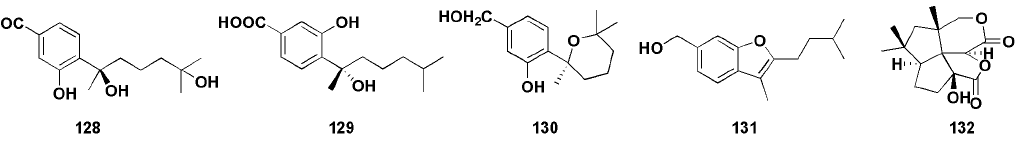
Figure 10. Structures of sesquiterpenoids obtained from chemical synthesis and biosynthesis from the Aspergillus sp. ( 128 – 132 ).